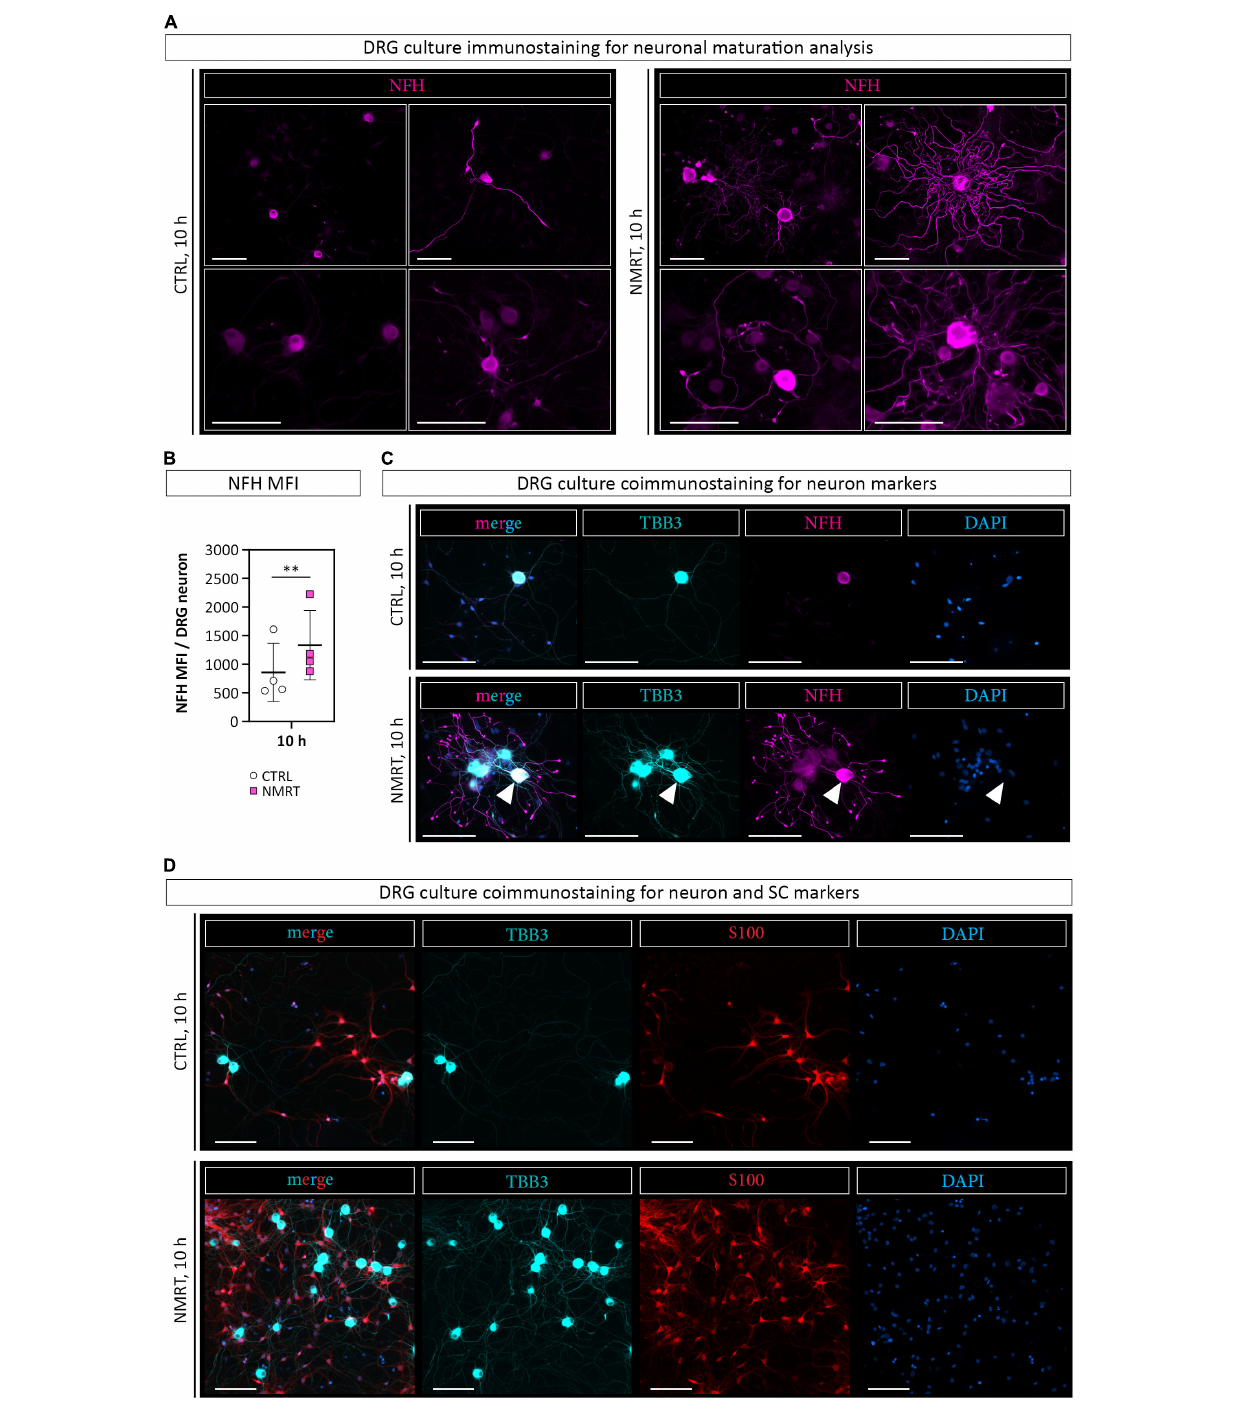
FIGURE 6 | Comparison of neuronal differentiation in response to NMRT. (A) Representative immunofluorescence images of control DRG cultures (left panel) and NMRT treated DRG cultures (right panel) after the 10 h treatment cycle stained for axonal maturation marker neurofilament heavy polypeptide (NFH, magenta). Scale bars represent 100 µ m. (B) Quantification of the NFH mean fluorescence intensity (MFI) per DRG neuron; data are depicted as single values for each donor of ± SD ( n = 4), two-way ANOVA, ∗∗ p < 0.01. (C) Representative immunofluorescence images of control DRG cultures (upper panel) and NMRT treated DRG cultures (lower panel) after the 10 h treatment regimen stained for TBB3 (cyan), NFH (magenta), and DAPI (blue). Scale bars represent 100 µ m. Note that all neuronal cell bodies and neurites are positive for TBB3, while only one neuron expresses NFH in the cell body and neurites (arrowhead). (D) Representative immunofluorescence images of control DRG cultures (upper panel) and NMRT treated DRG cultures (lower panel) after the 10 h treatment cycle stained for TBB3 (cyan), S100 (red), and DAPI (blue). An increased number of neurons and SCs is present in the NMRT treated cultures. Scale bars represent 100 µ m.